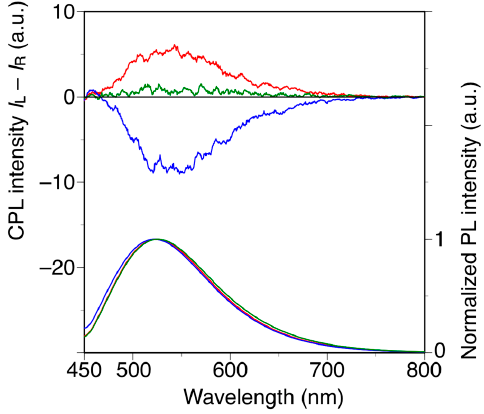
Figure 5. CPL and PL spectra of h -poly- 2 (blue line), h -poly-( 2 S 0.36 - co - 3 0.64 ) (red line) and poly-( 2 S 0.36 - co - 3 0.64 ) (green line) in DMF at 25 °C with excitation at 388 nm. [polymer] = 1.0 × 10 − 5 M.